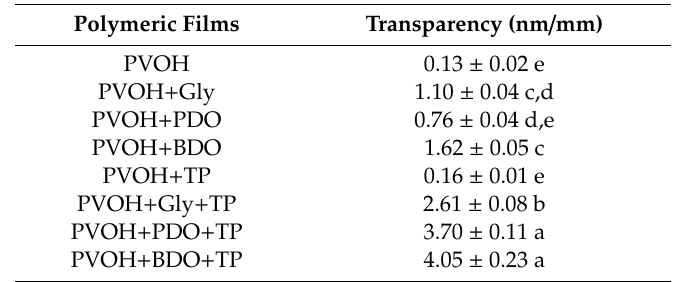
Table 3. The transparency of PVOH-based biofilms plasticized with polyols and incorporated with TP. Polymeric